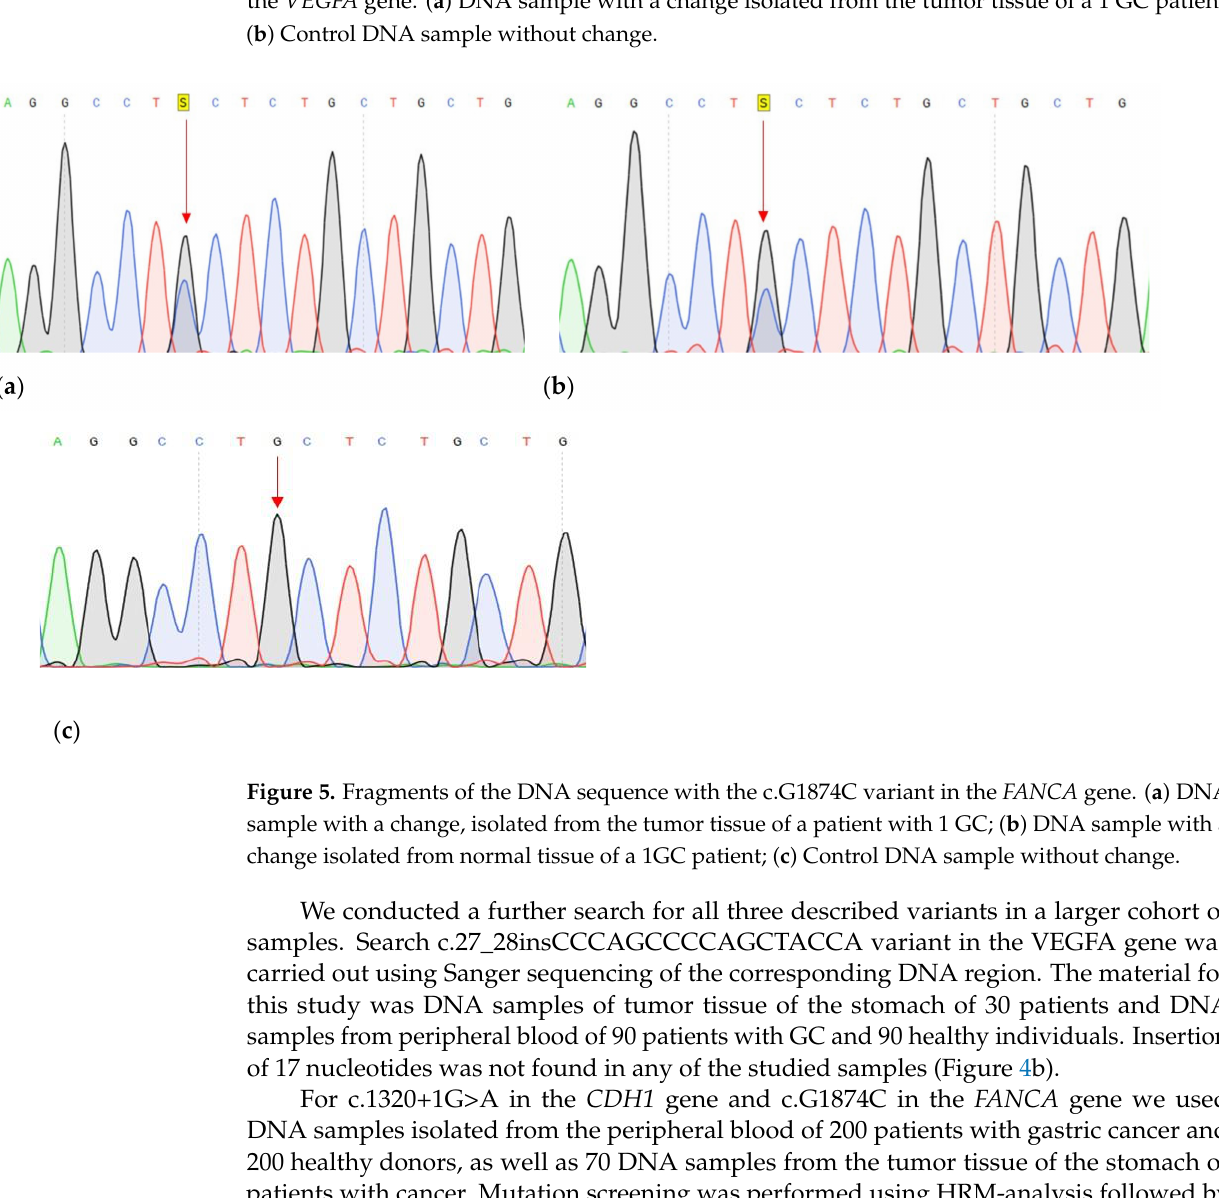
Figure 6. Derivatives of melting curves of amplicons obtained during PCR of a section of the CDH1 gene. ( a ) DNA samples without changes in the nucleotide sequence; ( b ) DNA sample with difference in melting point; ( c ) DNA sample with c.1320+1G>A (positive control). The patient was a 72-year-old woman with an established diagnosis of gastric cancer. Postoperative histological examination showed a highly differentiated adenocarcinoma of gastric cancer, which allows us to classify the patient ’ s intestinal type of gastric cancer.